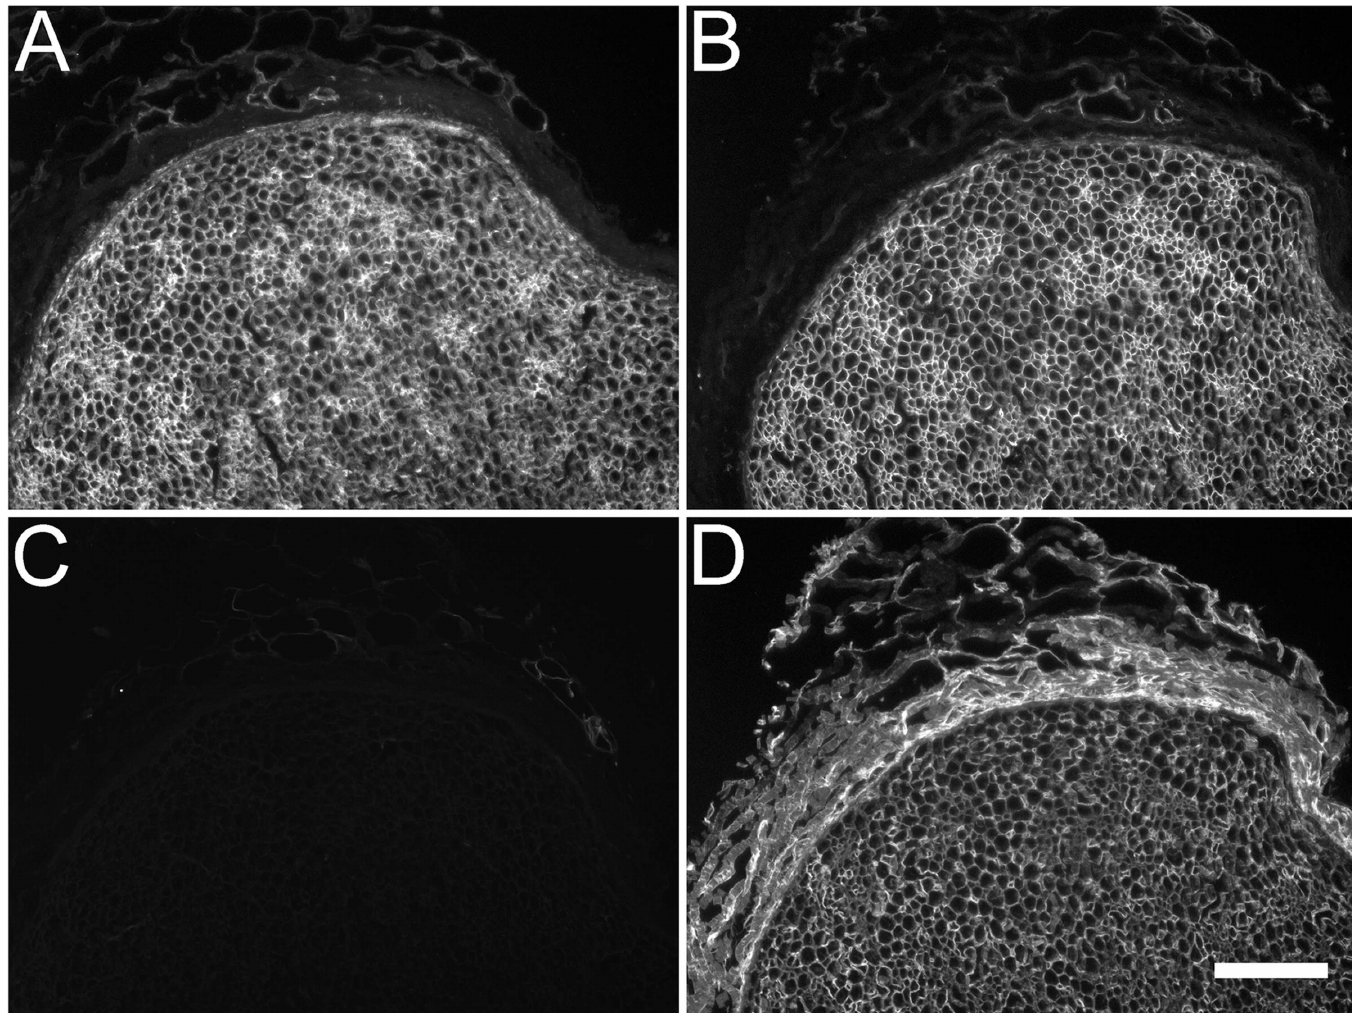
Fig 5. Chondroitinase C treatment on normal peripheral nerve reveals Δ CS-C only. Normal rabbit nerves were subjectedto chondroitinase C treatment only (A and C) or by an additionaltreatment of chondroitinase ABC (B and D). Tissue was then labeledwith Δ CS-C (A and B) or Δ CS-A (C and D) antibodies (C6S or C6S respectively). (A) C6S was present exclusivelywithin the endoneurium of chondroitinase C treated nerve. (B) A secondary chondroitinaseABC treatment did not reveal any additionalC6S immunoreactivity indicatingthat chondroitinase C effectively degradedthe CS-C glycosaminoglycan chains. (C) Chondroitinase C treatment did not create Δ CS-A immunoreactivity, which providedevidenceof substrate specificity. (D) A secondary chondroitinase ABC treatment did reveal the C4S neoepitopeconfirmingthat chondroitinase C is selective for CS-C glycosaminoglycanchains. Scale bar: 100 μ